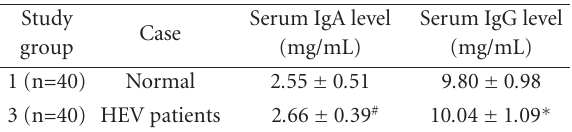
Figure 2. Serum IgM levels in groups of HEV-infected sera and una ff ected control measured by ELISA. Comparison of average serum IgM (mean ± SD). Table 1. Statistical analysis of IgA and IgG measured by ELISA. (Values are mean ±